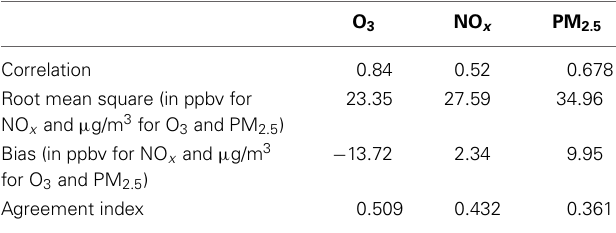
Table 8 | Statistical parameters indicating the quality of the simulation for the period of January–February